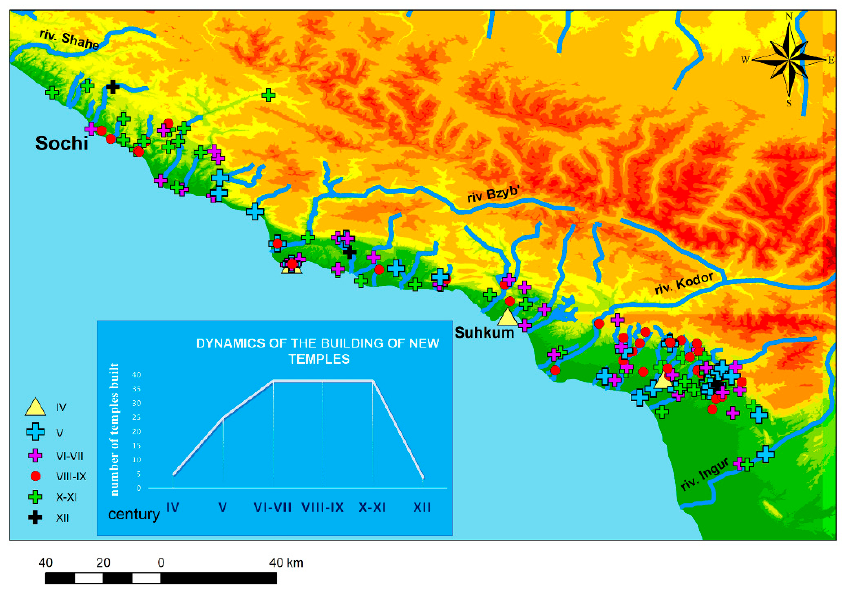
Figure 2. Map of temples with a chronological classification according to the date of construction of the temple.